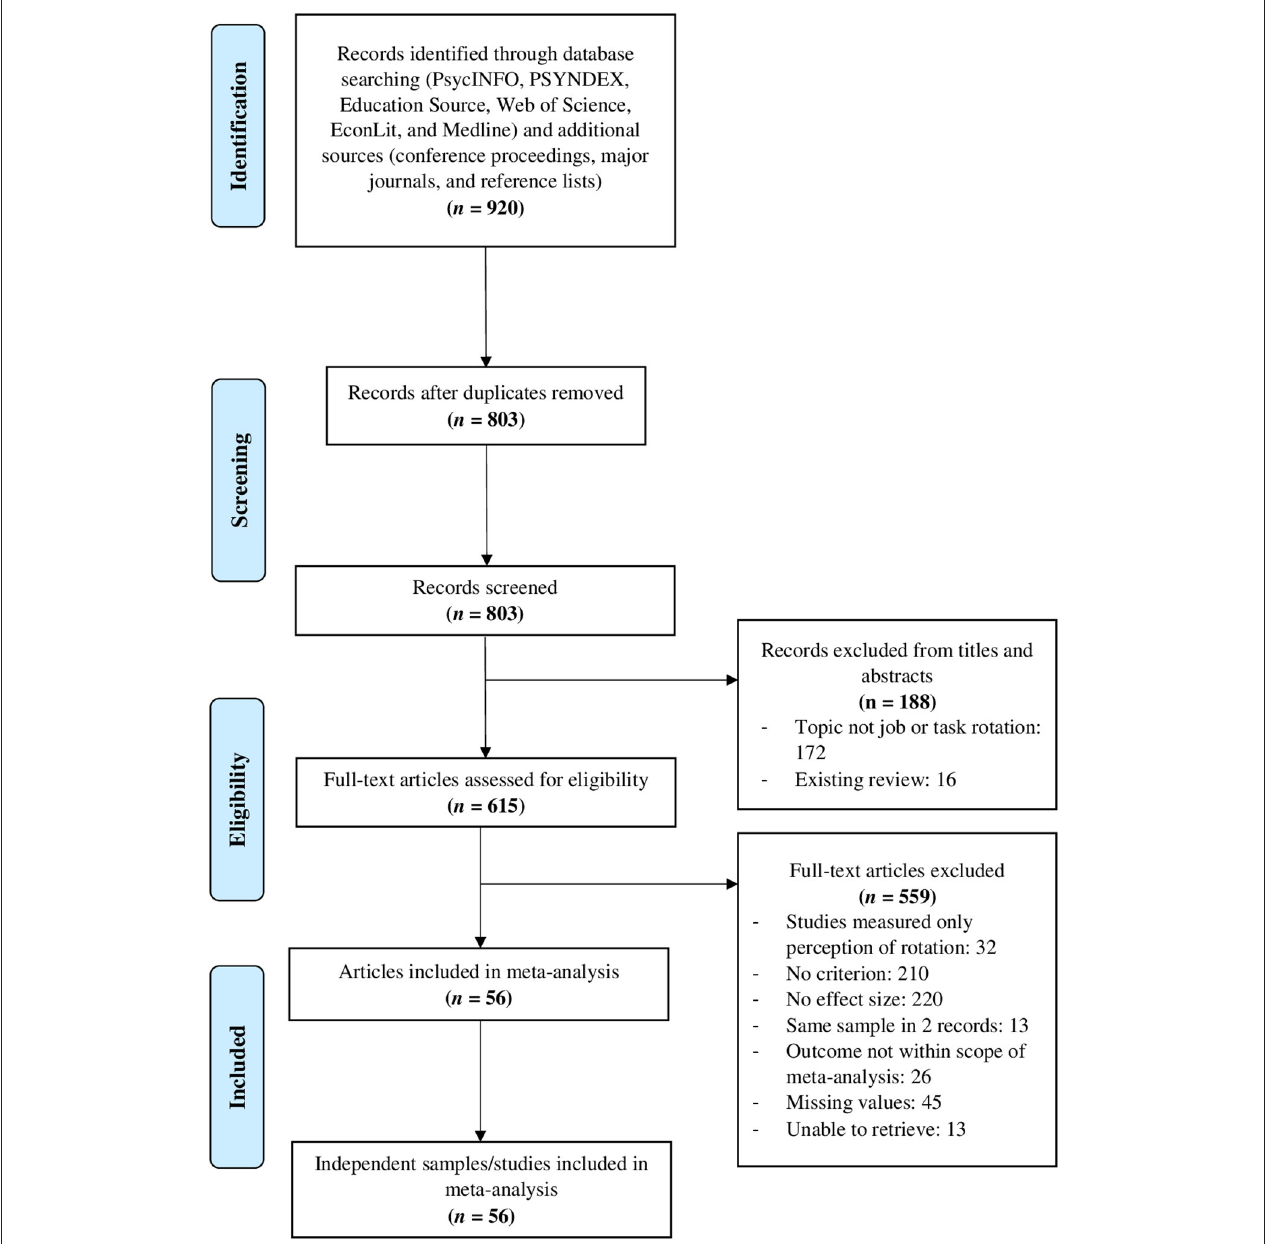
FIGURE 1 | Flow chart with reasons for article exclusions.